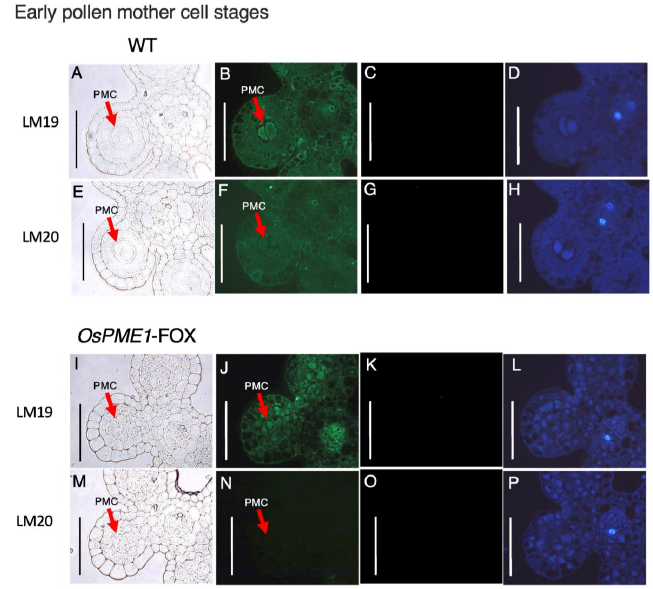
Figure 6. Immunohistochemistry of resin-embedded anther sections of early pollen mother-cell stages in WT and OsPME1 -FOX. ( A , E , I , M ) Tissue cross-sections from the WT and OsPME1 -FOX were observed under bright-field illumination. ( B , F , J , N ) Sections were stained with LM19 (anti-demethyl-esterified pectin) and LM20 (anti-methyl-esterified pectin) monoclonal antibodies. ( C , G , K , O ) The negative control, in which the first antibody step was omitted. ( D , H , L , P ) Autofluorescence excited by UV irradiation. All experiment was biologically repeated at least four times independently with similar results. PMC, pollen mother cell. Bars, 50 µm.